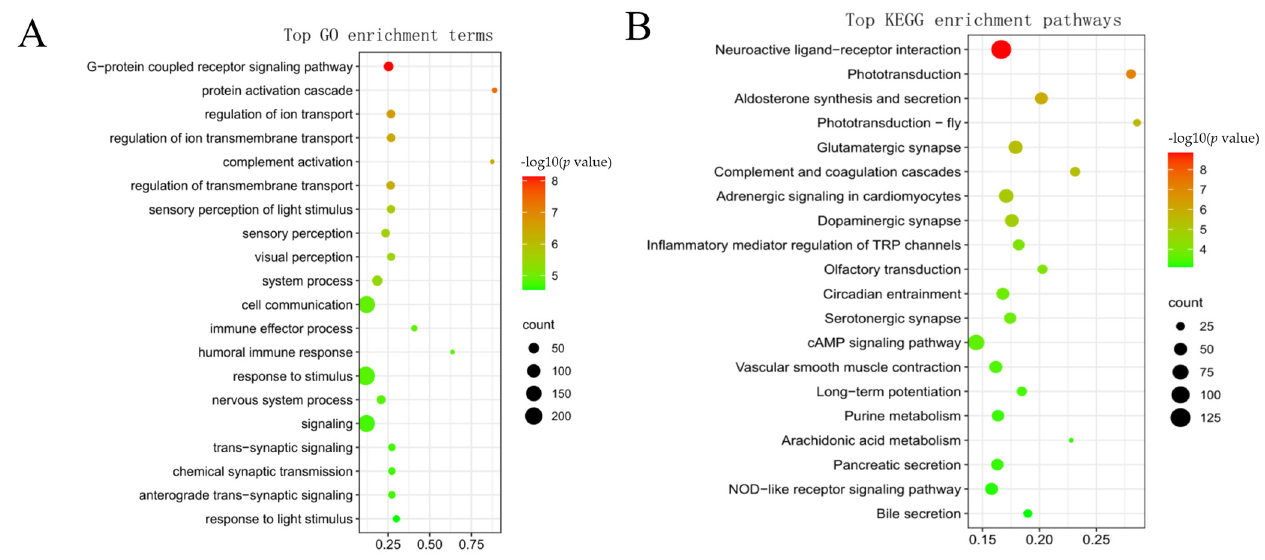
Figure 4. Enrichment analysis of genes in Profile 19: ( A ) The top 20 enrichment GO (gene ontology, biology process) terms ( p < 0.05); ( B ) the significantly enriched Kyoto Encyclopedia of Genes and Genomes (KEGG) pathway ( p < 0.05).